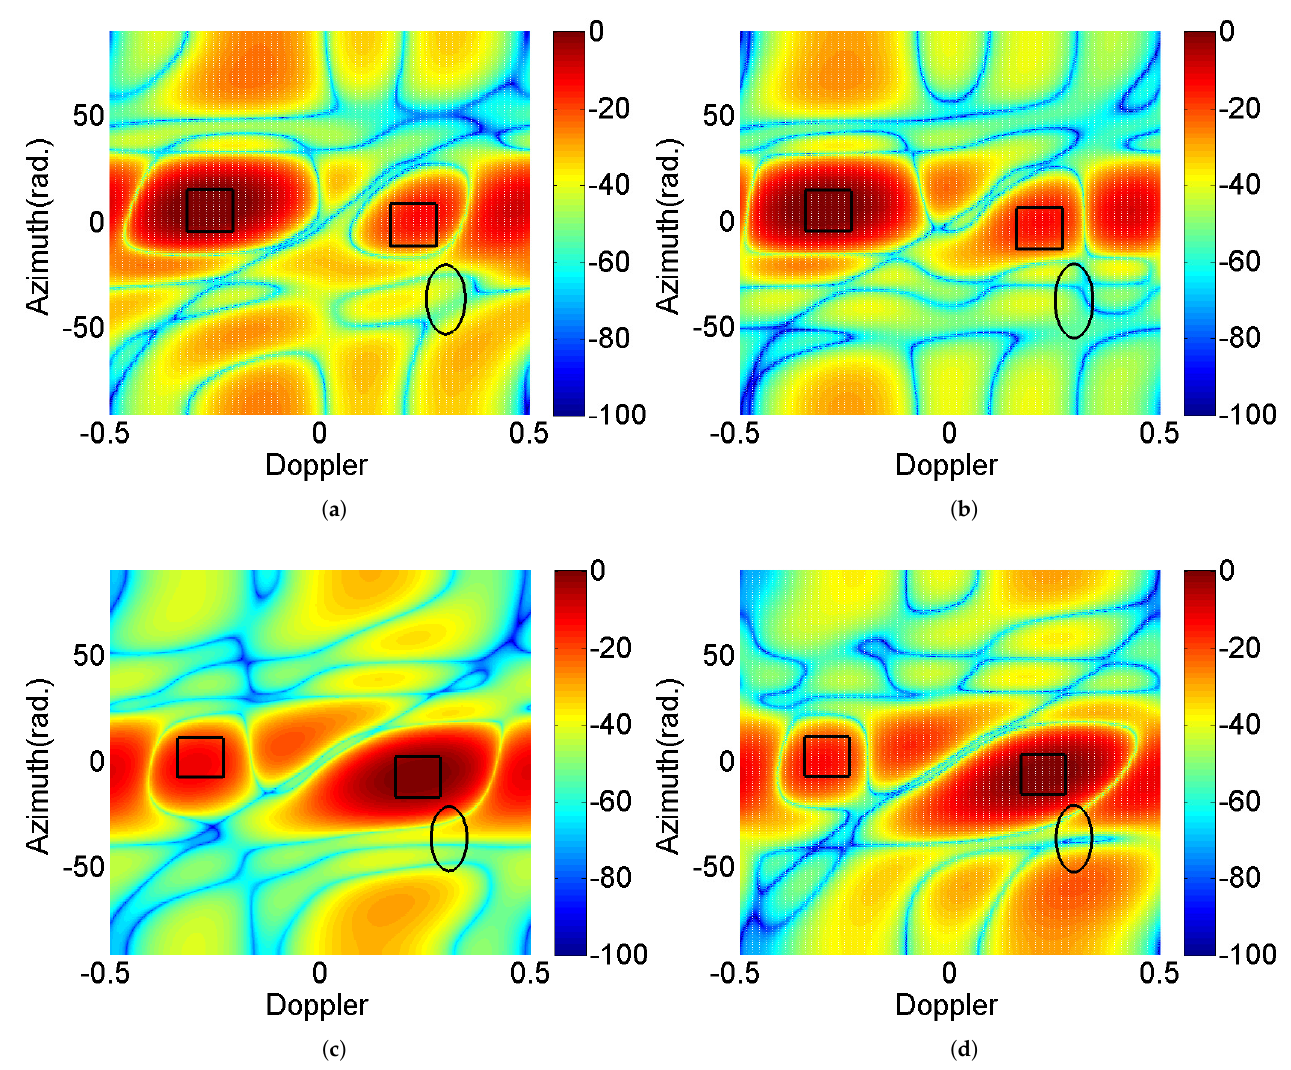
Figure 4. Doppler-azimuth plane of CAF of radar multi-targets for outer iteration number k 2 = { 10,40 } : ( a ) w ∗ and s ∗ , k 2 = 10, ( b ) w ∗ and s ∗ , k 2 = 40, ( c ) w ∗ and s ∗ , k 2 = 10, ( d ) w ∗ 2 2 1 1 and s ∗ , k 2 = 40 (solid line rectangles and ellipse respectively denote the locations of the radar targets, the interference sources from communication